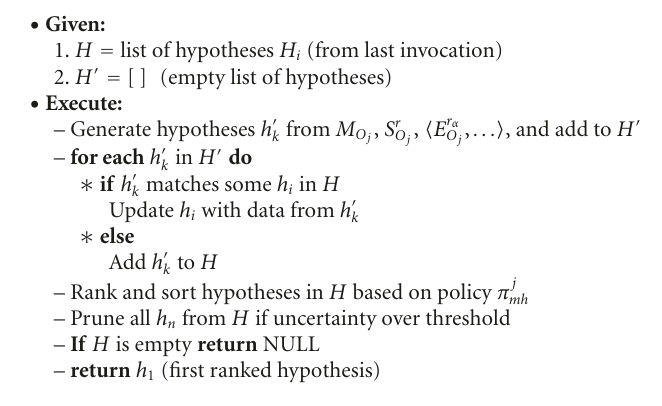
Algorithm 1: Definition of hypothesis ranking